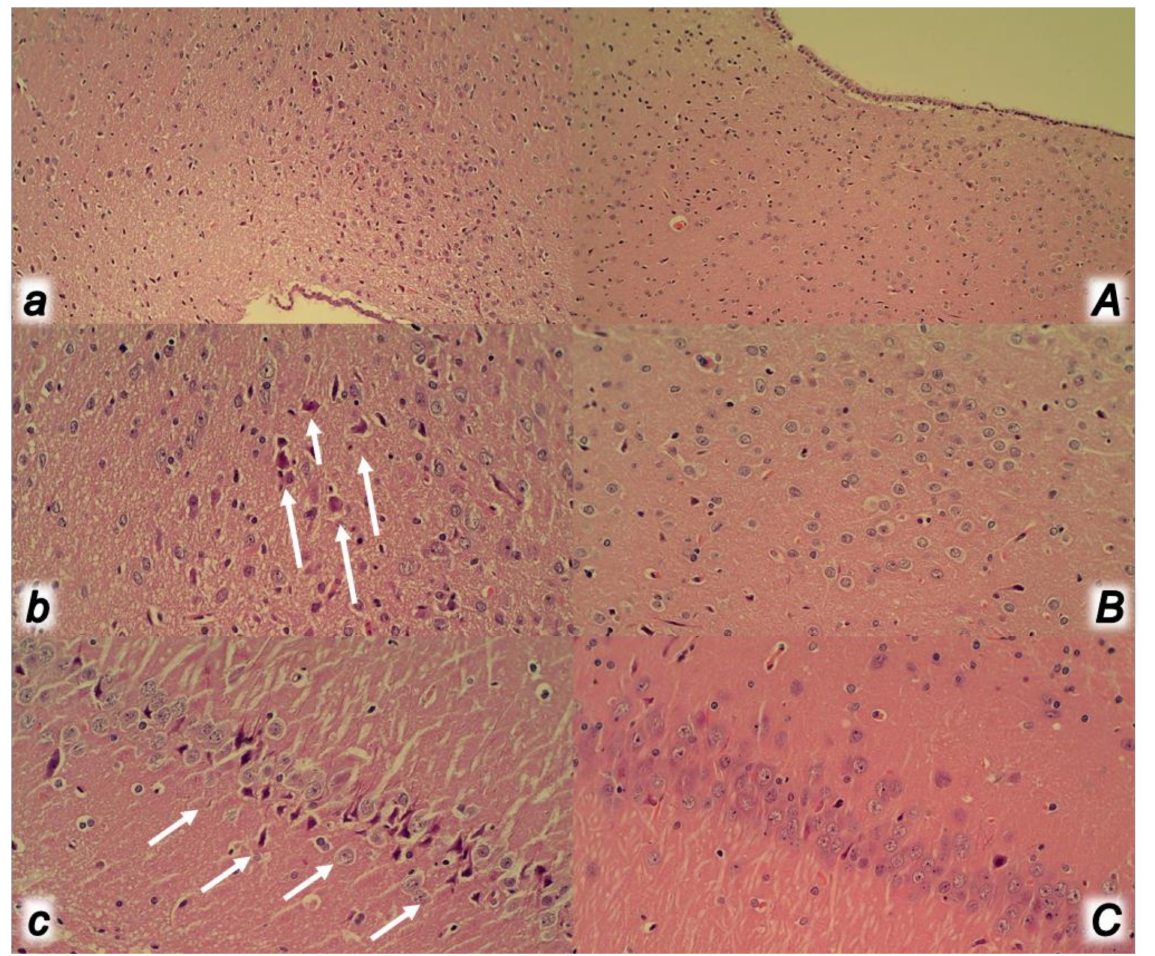
Figure 14. At 30 min ligation-time, microscopy presentation of the neuropathologic changes in the hypothalamus ( a , A (HE, × 100), b , B (HE, × 200)) and hippocampus ( c , C (HE, × 200)) in the rats with occluded superior mesenteric vein and artery, controls (small letters) and BPC 157 treated (capitals). Control rats with occluded superior mesenteric vein and artery exhibited in the hypothalamus and hippocampus edema ( a , c ) and karyopyknosis of the hypothalamic (arrows) ( b ) and hippocampal (arrows) ( c ) cells; only minimal hypothalamic edema in BPC 157 ( A ) and no karyopyknosis of the hypothalamic cells ( B ), and no changes in the hippocampus ( C